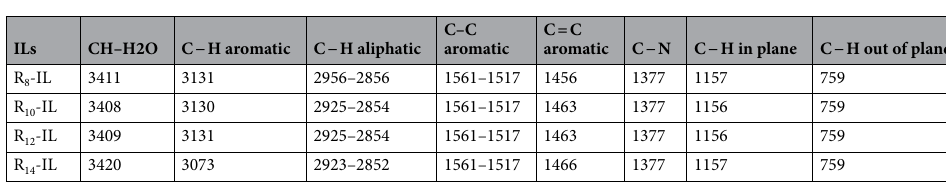
Table 4. FT-IR data of the prepared ILs.